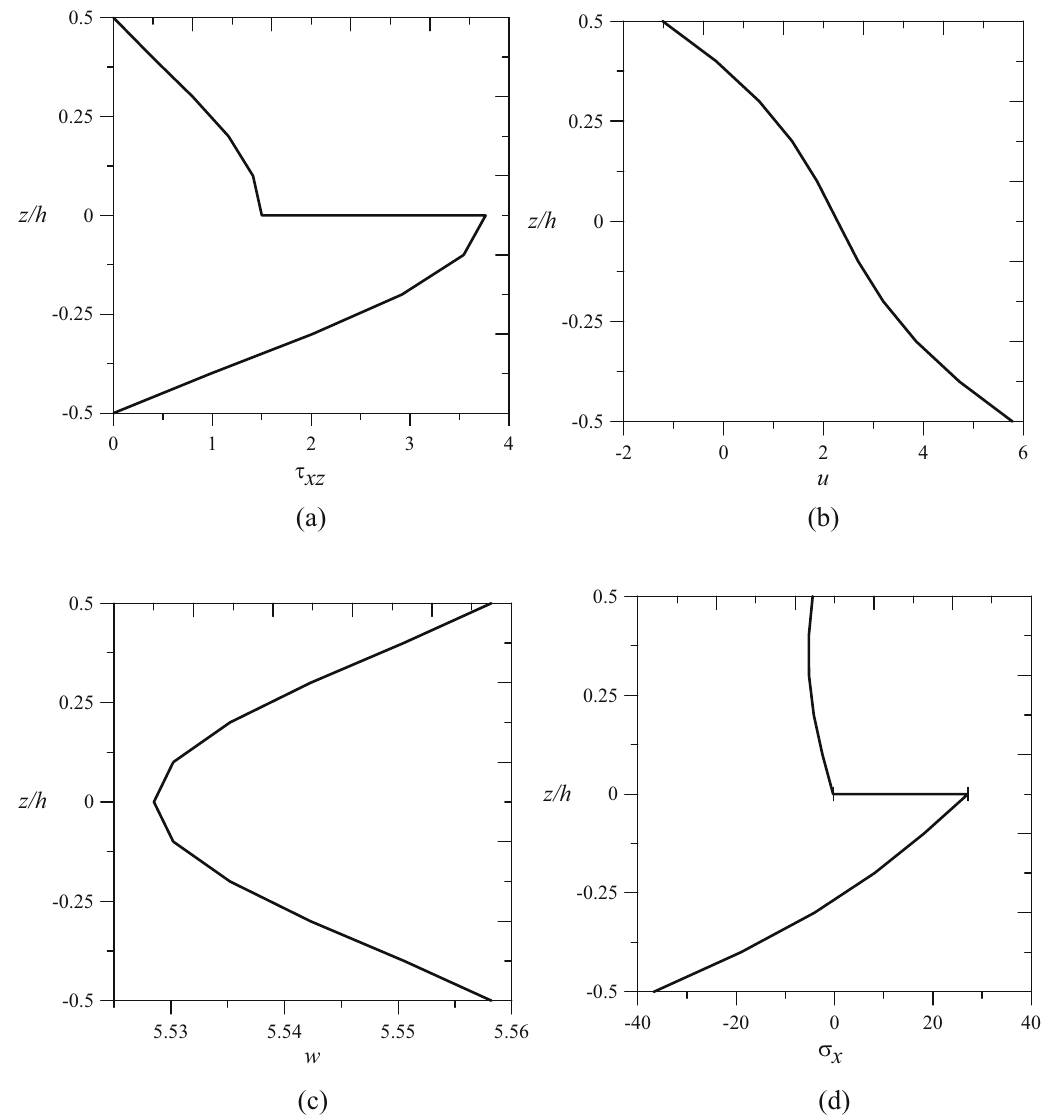
Figure 2: Variation through the thickness for transverse shear stresses ( a ) , axial displacements ( b ) , transverse displacements ( c ) , and axial bending stresses ( d ) for antisymmetric two - layered ( 0°/90° ) composite arches subjected to UDL ( R / h = 5; L / h = 4 )